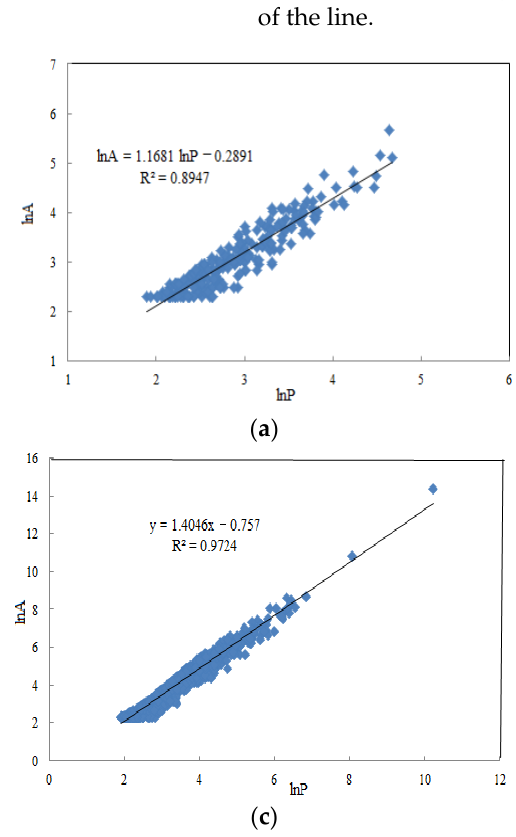
Figure 8. D 2f values of flocs treated by three methods ( a ) PAC ( b ) PAC+PAM ( c ) magnetic flocculation.